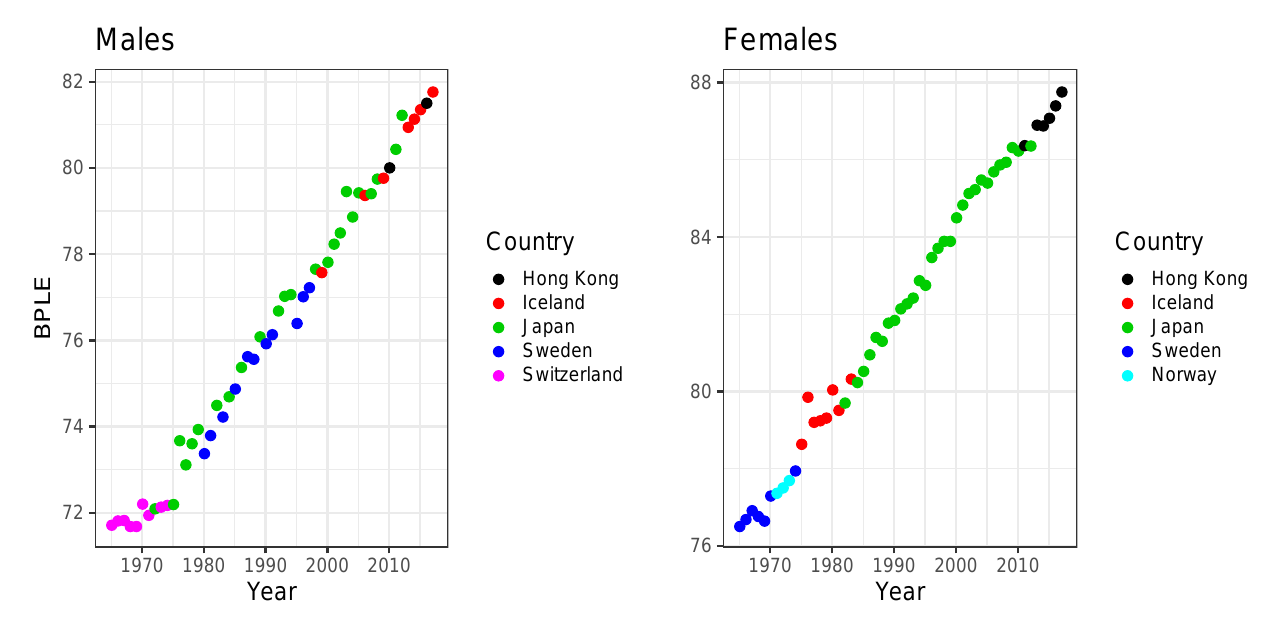
Figure 1. Best practice male and female life expectancies at birth, 1965–2017.